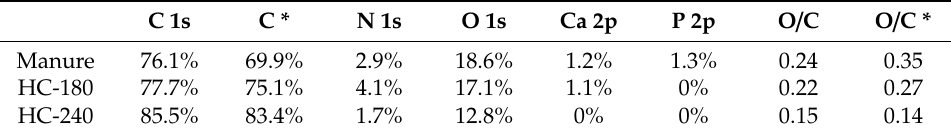
Table 3. The atomic composition of char and manure surfaces.